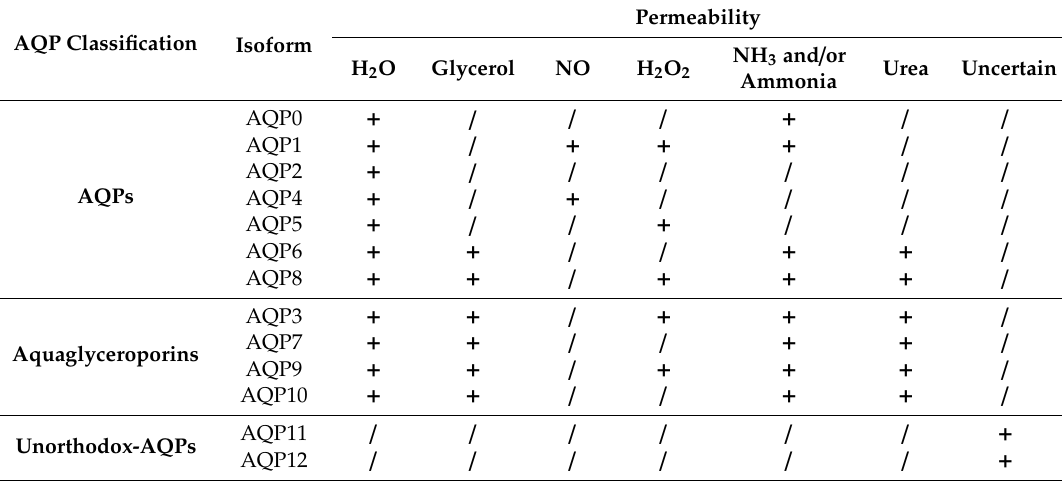
Table 1. Classification and permeability characteristics of